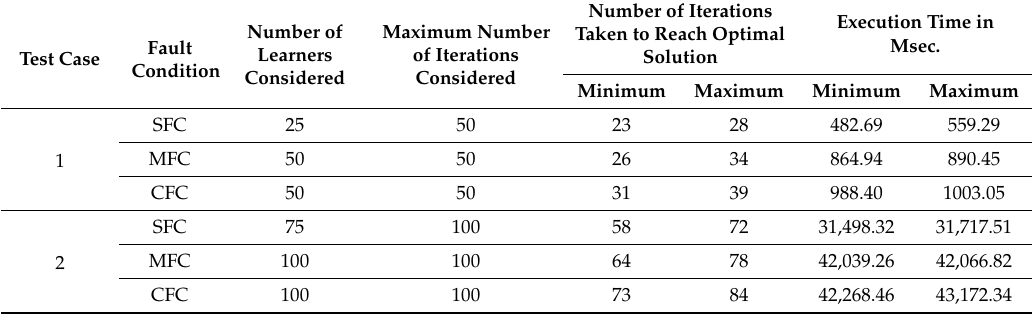
Table 11. Set parameter values of TLA and iterations conceded under di ff erent fault